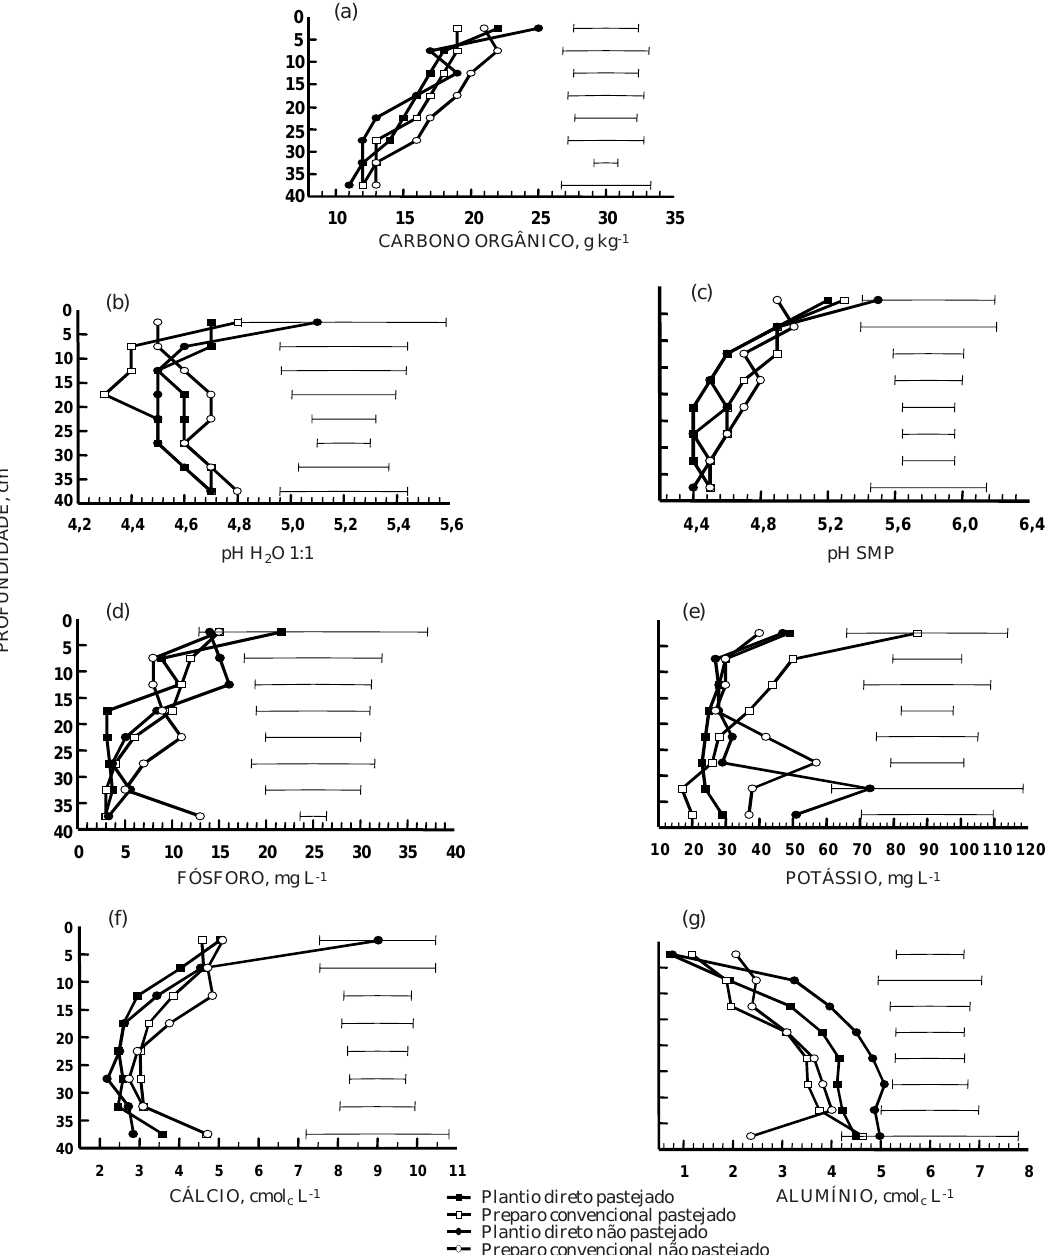
Figura 4. Carbono orgânico do solo (a), pH H O (b), pH SMP (c), fósforo disponível (d), potássio disponível 2 (e), cálcio trocável (f) e alumínio trocável (g), ao longo da profundidade, em solo sob plantio direto e preparo convencional, ambos anteriormente com e sem pastejo. Linhas horizontais indicam a diferença mínima significativa a 5% (DMS) e comparam médias dos tratamentos em cada